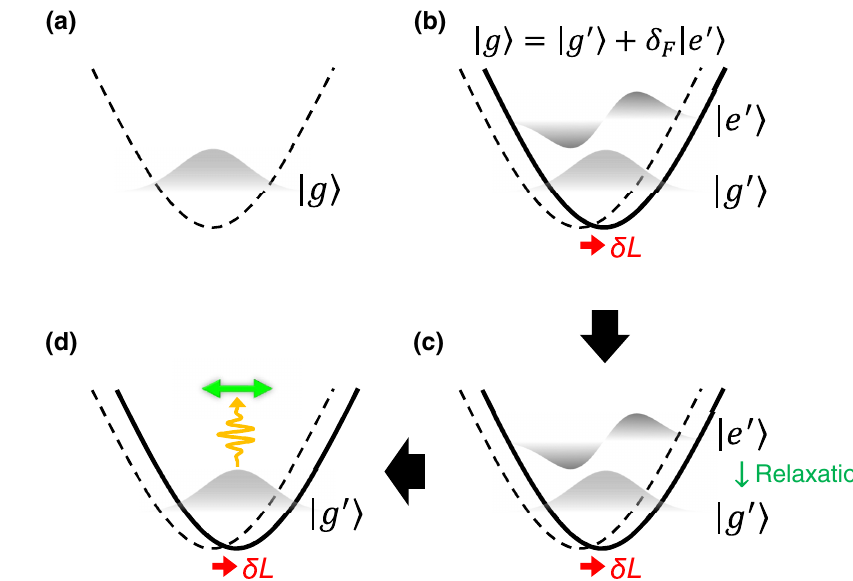
FIG. 7. (a) A ground state exciton wave packet initially at a balanced site, where the potential profile for the c.m. motion is denoted by the dashed curve, centered at B . (b) After the annihilation of a nearest neighbor, the exciton concerned feels an unbalanced dipolar force which changes the potential profile to the solid curve with a displaced center. The ground state and first excited state in this new potential profile are denoted as j g 0 i and j e 0 i , respectively. The initial wave function is their superposition: j g i ¼ j g 0 i þ δ scattering, the j e 0 i constituent of the wave function relaxes to the ground state j g 0 i in a timescale orders faster than the radiative decay of either j g 0 i or j e 0 i . (d) The subsequent radiative emission from j g 0 i . Note that the envelope functions shown in this figure are all for the primary X component of the exciton wave inter